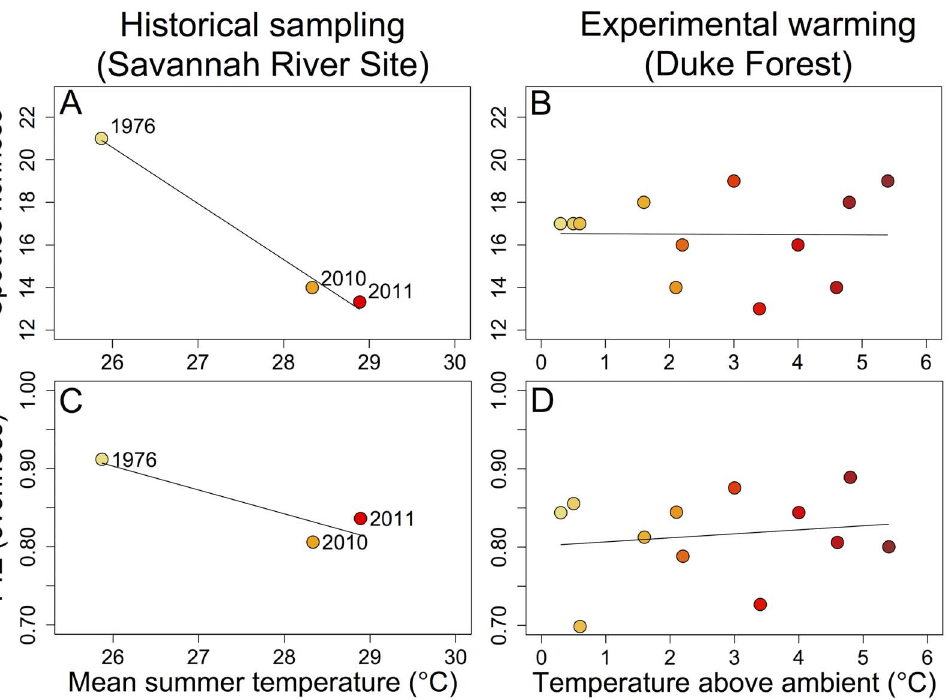
Figure 2. Relationships between temperature and ant diversity. Components of diversity are: species richness (A–B), evenness (C–D) at Savannah River Site (A, C) and Duke Forest (B, D). Dots for Savannah River Site represent sampling periods and dots for Duke Forest represent warming chambers. Warmer colors indicate warmer temperatures.